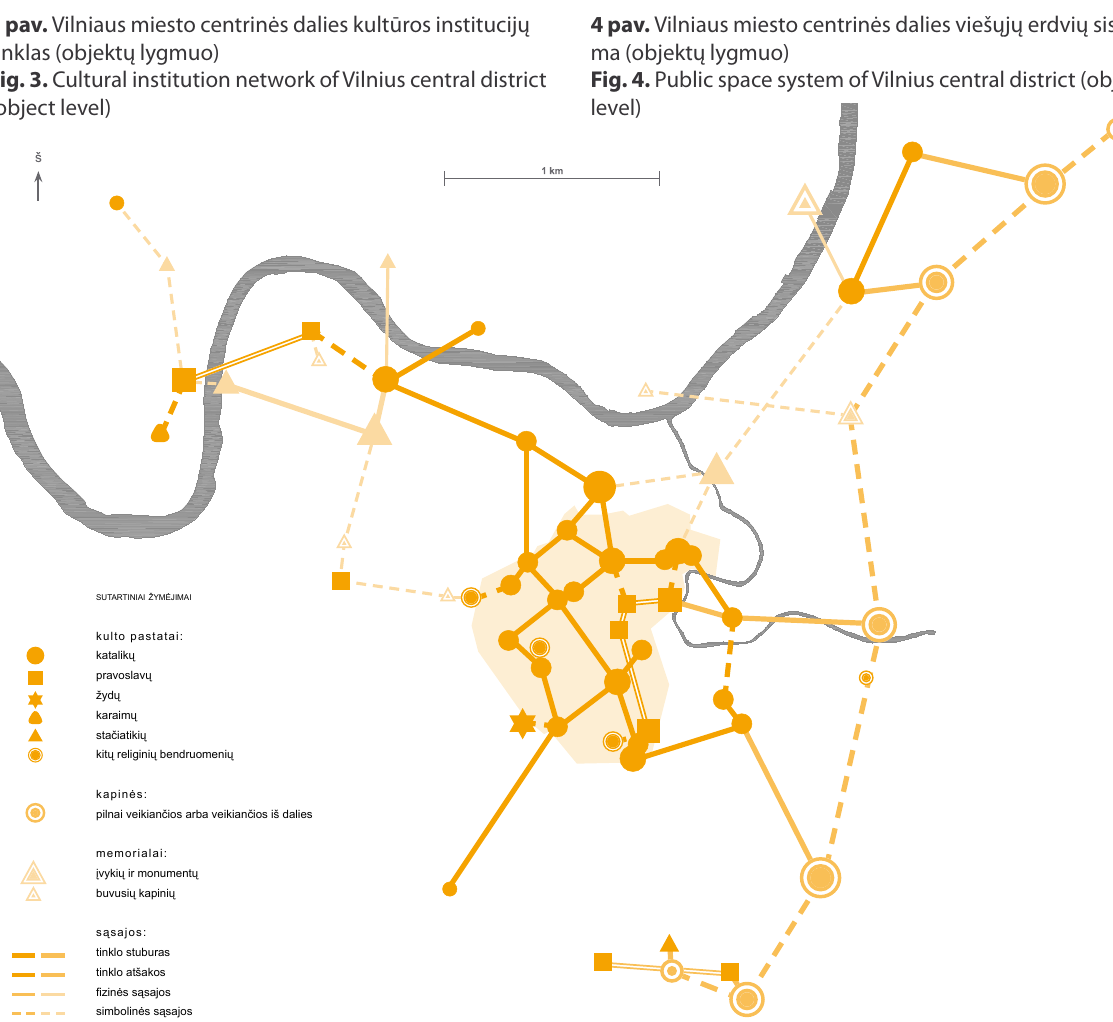
Fig. 5. network of memorial and cult object in Vilnius central district (object level)